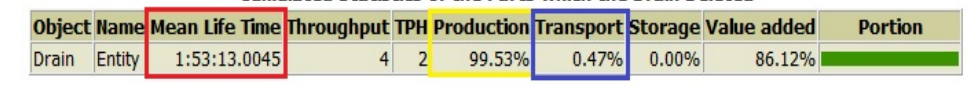
Figure 10. Statistics of simulated process after applied changes.